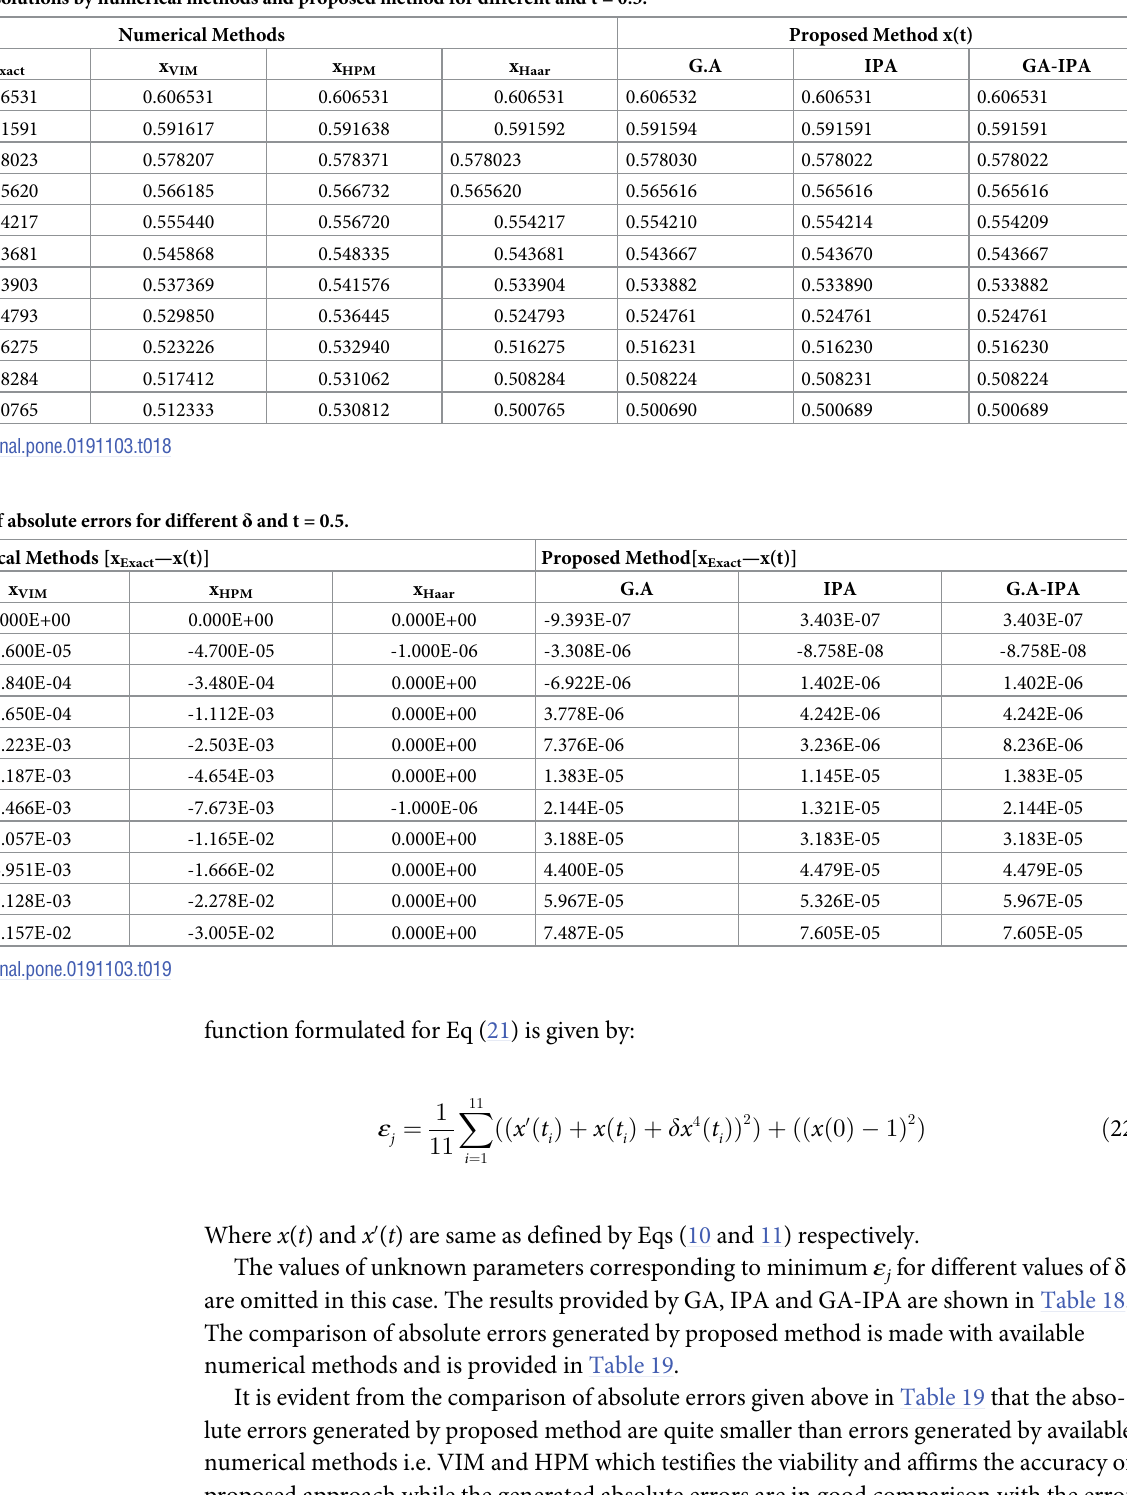
Table 18. Approximate solutions by numerical methods and proposed method for different and t = 0.5.